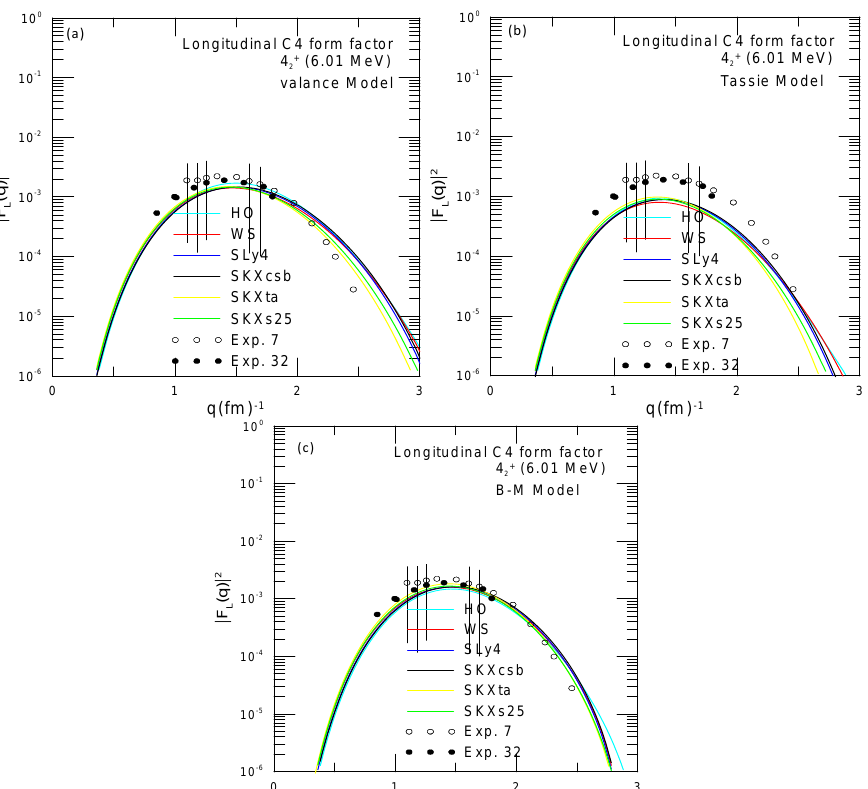
Fig.7: Theoretical longitudinal form factors for the second 4 + , 6.01 MeV state using different single particle potential compared with the experimental data taken from Ref. [7,